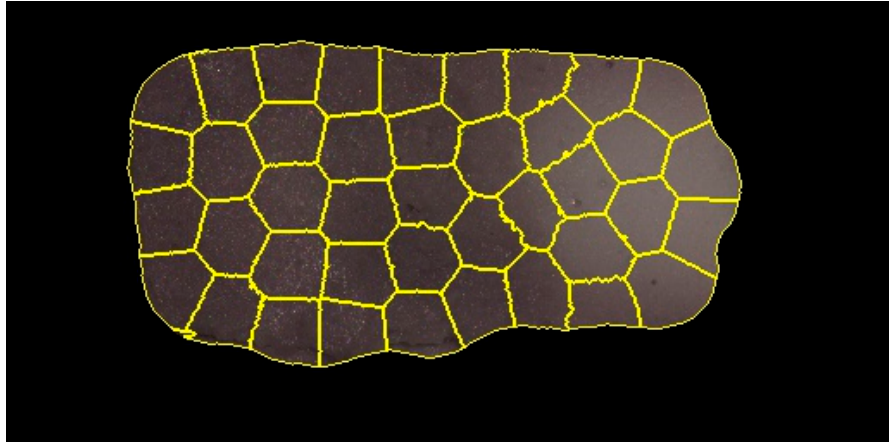
Figure 5. Non-overlapping regions of a mashed-potato HSI image.